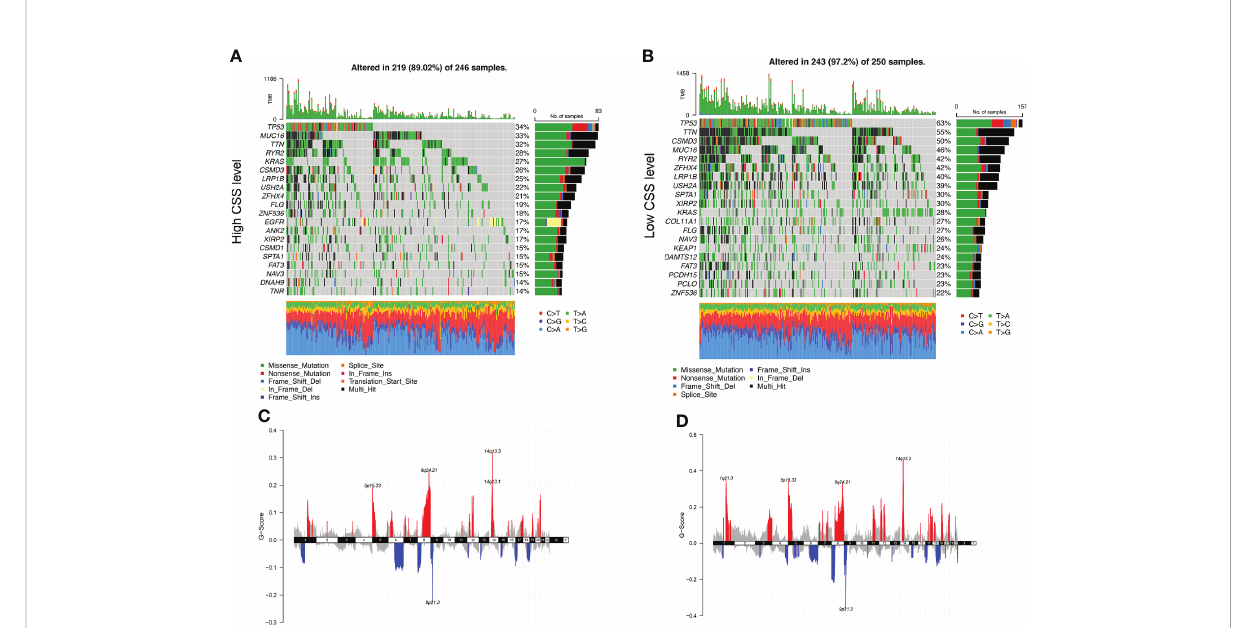
FIGURE 9 Genomic alteration of different CSS subgroups. (A, B) The waterfall plot of somatic mutation features established with high and low CSS subgroups. Each column represented an individual patient. The upper barplot showed TMB, the number on the right indicated the mutation frequency in each gene. The right barplot and color coding showed the proportion of each variant type. (C, D) Distribution of copy number ampli fi cation and deletion regions in high and low CSS subgroups. Red is ampli fi cation, and blue is deletion. CSS, cuproptosis scoring system; TMB, tumor mutation burden.